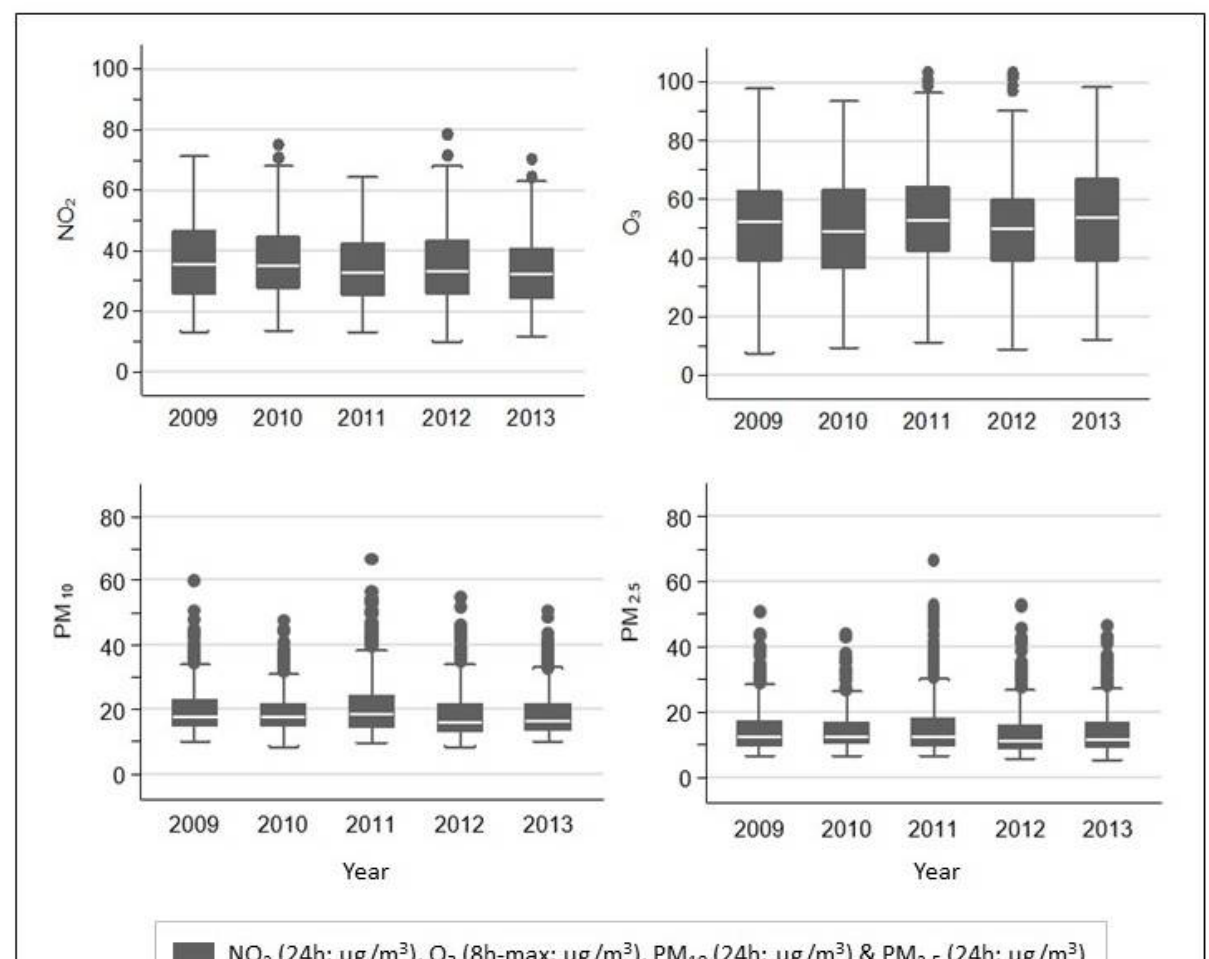
Figure 3. Yearly average (years 2009 to 2013) of estimated NO 2 (24 h; µ g/m 3 ), O 3 (8 h-max; µ g/m 3 ), PM10 (24 h; µ g/m 3 ) and PM2.5 (24 h; µ g/m 3 ) concentrations from the hybrid 2 model, in the Greater London Area. Hybrid 2: Combination of estimates derived from independent exposure assessment methods, within a GAM.